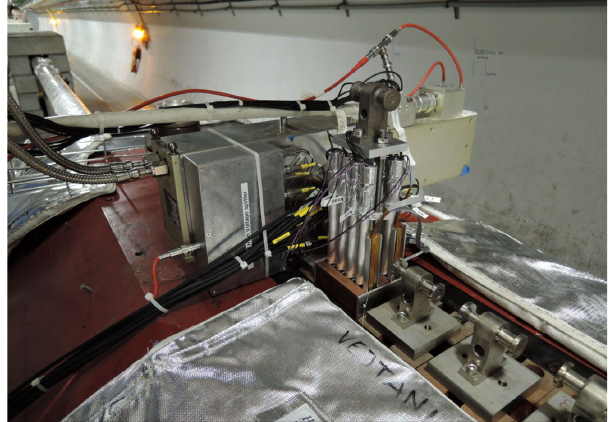
FIG. 2. BRAN prototype as installed in 2016 in the TAN on Arm 8-1 of IP1.